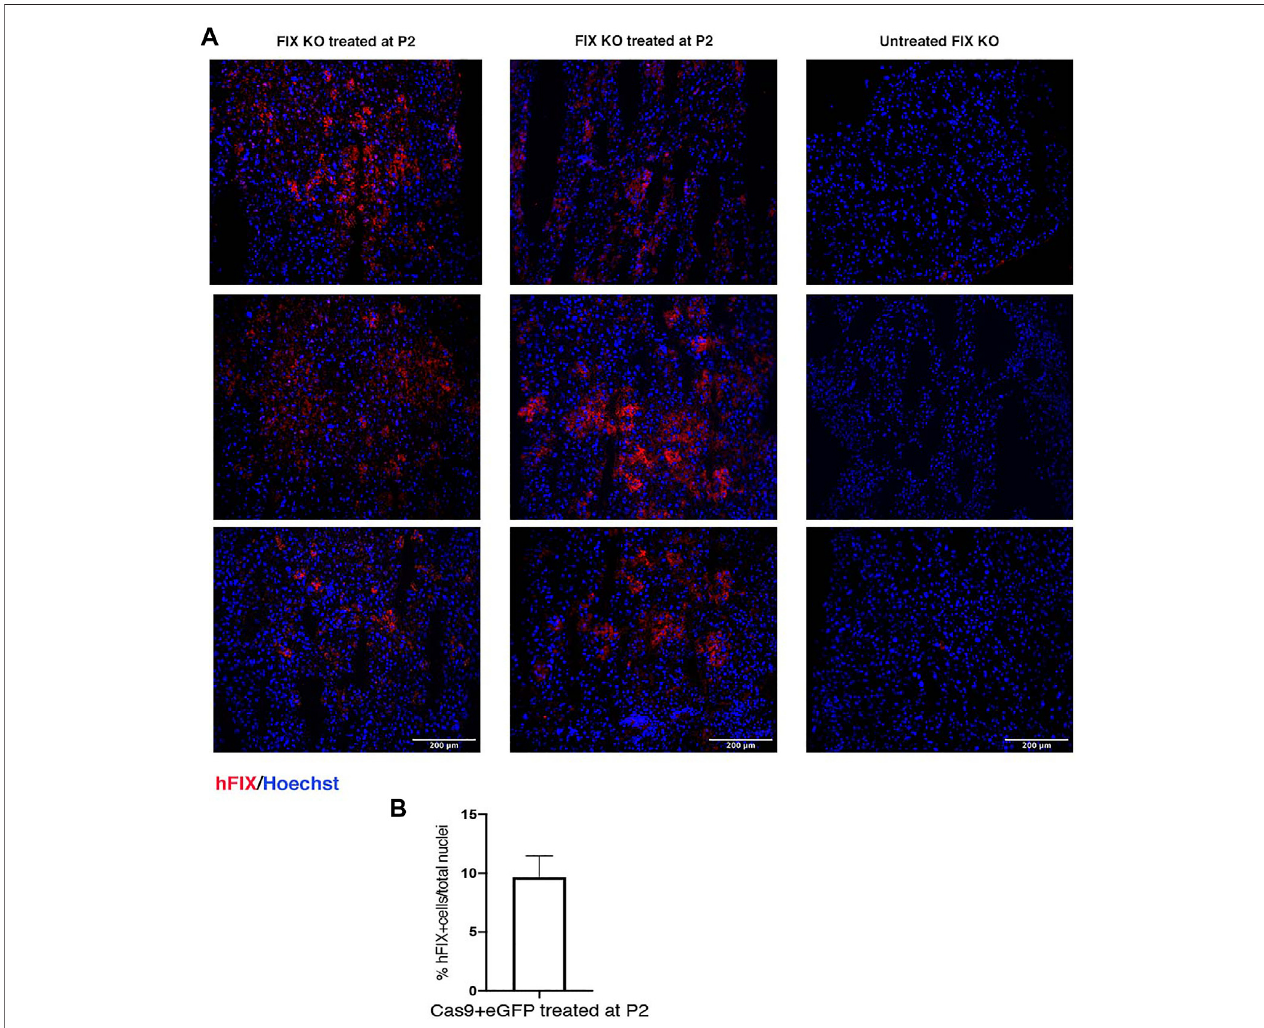
FIGURE 3 | Immunohistochemical analysis of liver section. (A) hFIX protein was detected in liver sections of FIX KO mice treated at P2 with rAAV8-SaCas9 and rAAV8-donor-hFIX.Sectionswerestainedwithanti-hFIXantibody(red)andnucleiwerecounterstainedwithHoechst(blue).Scalebar,200 μ m; (B) Quanti fi cationofhFIX positive cells normalized by total cell